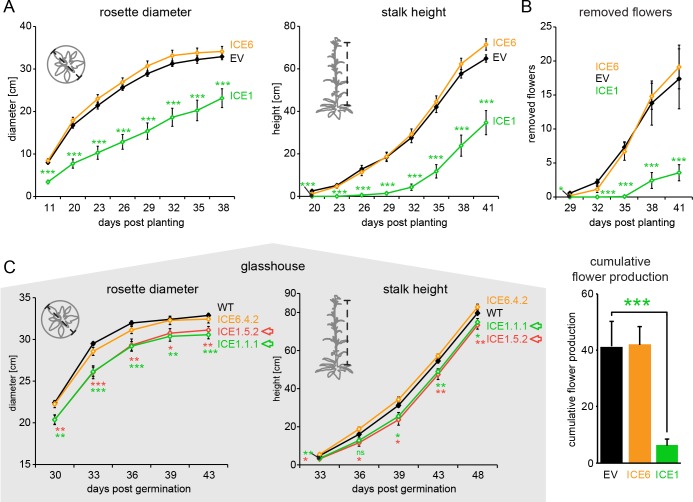
Off-target effects of the plant transformation process dominate growth performance of line ICE 1.Growth comparisons of transgenic N. attenuata ICE 1 and ICE 6 in the field and the glasshouse. (A) During the first field season, ICE 1 plants showed a severe reduction in rosette diameters and stalk heights compared to the controls (EV) (±SEM, n = 14–16 plants). Asterisks indicate statistically significant differences. (Mann-Whitney U Test, following Kruskal-Wallis Test; ***p≤0.001). (B) Elongated flowers and flower buds were removed and counted every 3 d before opening. For total flower numbers, the cumulative flower productions per genotype was summed from 29 to 41 d post planting (dpp). ICE 1 showed significant reductions in flower numbers. Asterisks indicate statistically significant differences to the controls (Mann-Whitney U Test; ***p≤0.001) (C) Glasshouse experiments comparing diameter and stalk height of transgenic plants to WT controls. Both ICE 1 lines (from a single regeneration event) showed a minor reduction in growth (red and green arrow) (±SEM, n = 8 plants, WT and ICE 6 n = 16). Asterisks indicate statistically significant differences compared to the controls (Mann-Whitney U Test, following Kruskal-Wallis Test; *p≤0.05; **p≤0.01; ***p≤0.001).